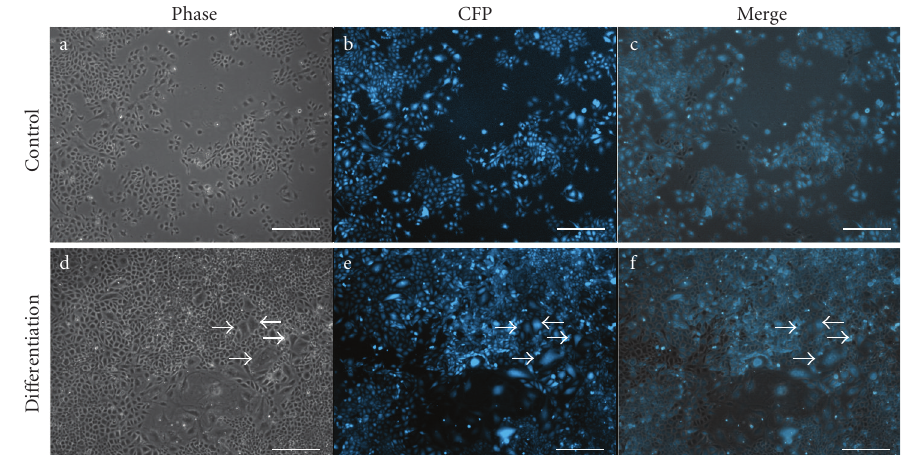
Figure 4: Qualitative comparison of CFP-fluorescent B3 cells under control and di ff erentiating culture conditions. Clone B3 cells were cultured under routine (control) (a)–(c) or di ff erentiating (d)–(f); 20ng/ml epidermal growth factor, 0.5 ng/ml transforming growth factor b, 1% serum) culture conditions for 9 days. Shown are phases (a), (d), fluorescent (b), (e), and merged (c), (f) images. Arrows indicate morphologically di ff erentiated cells. Scale bar is equivalent to 100 μ m.